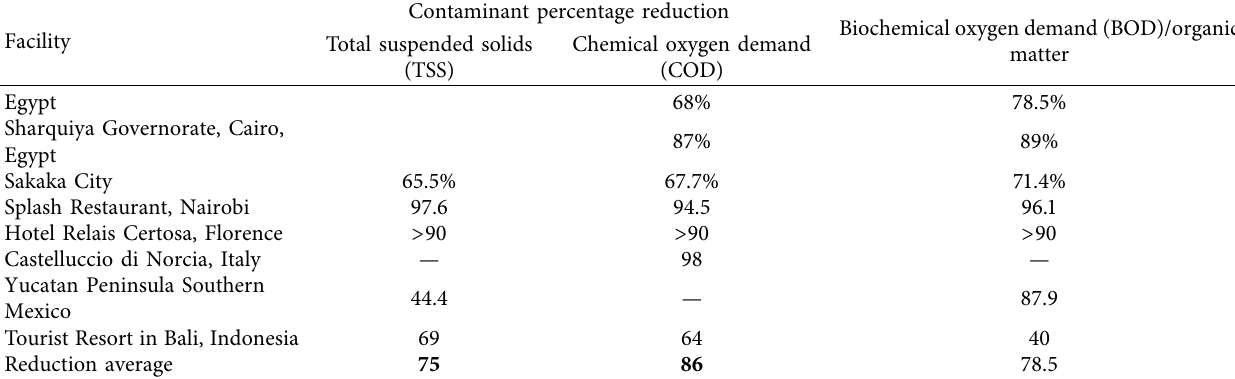
Table 1: Summary of CW case studies indicating specific reduction load